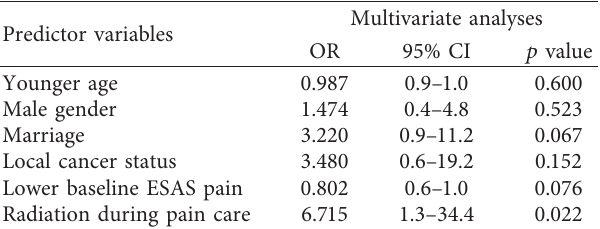
Table 6: Multivariable logistic regression results for predicting pain responders at